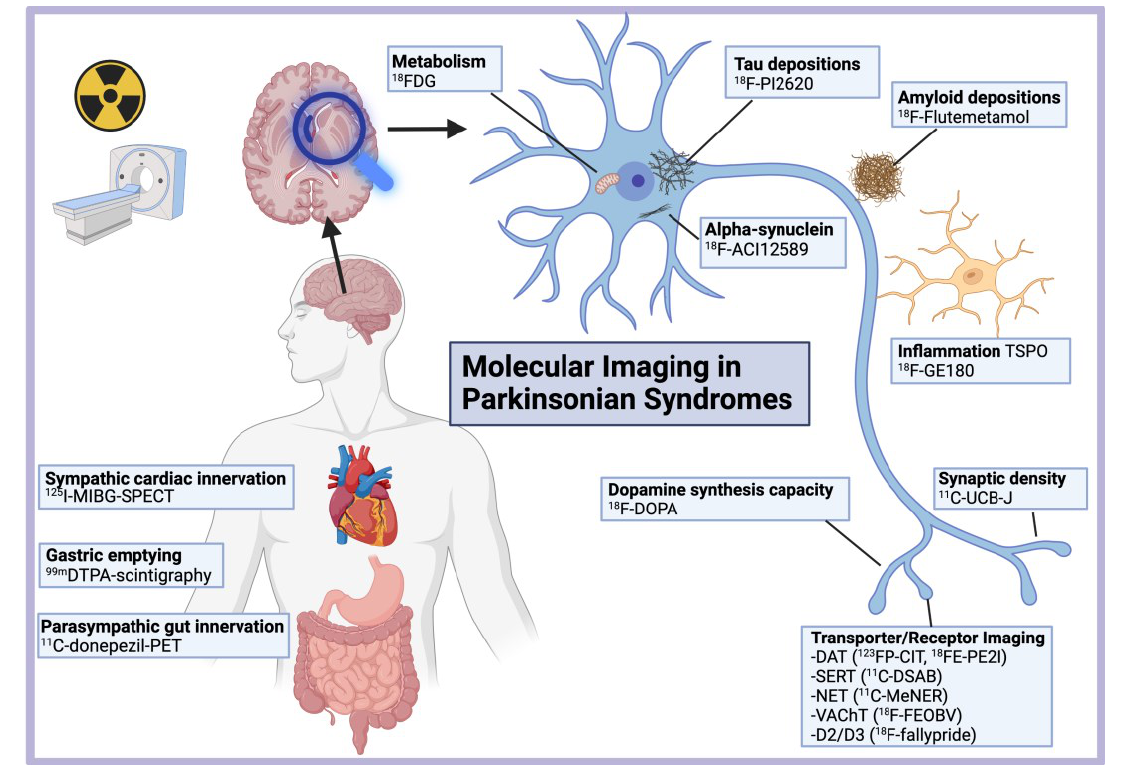
Figure 1. Molecular imaging in parkinsonian disorders. Created with Biorender.com (accessed on 15 March